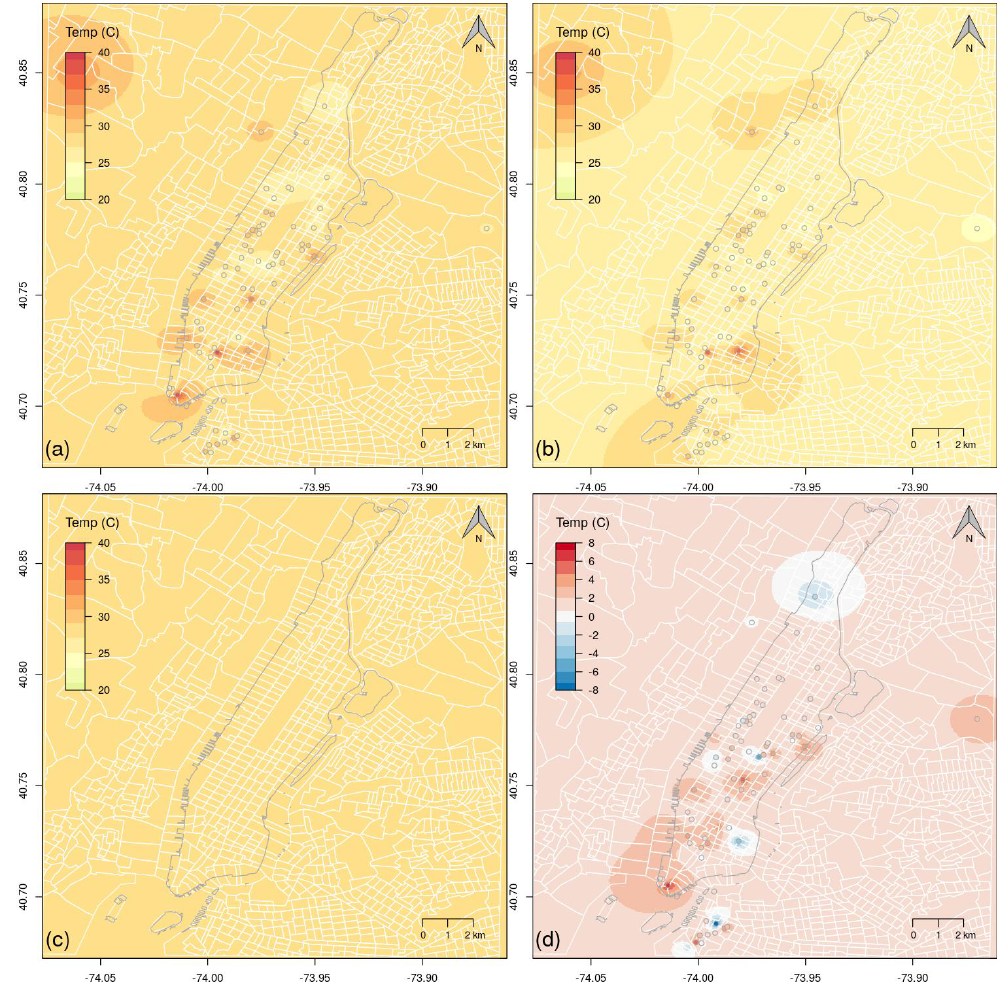
Figure 7. AnEn spatial downscaling for 8 August 2016 and forecast lead time 16 (12 p.m. local time)—The figure shows the observed values from the WU stations ( a ), the AnEn ensemble mean ( b ), the NAM-NMM prediction ( c ) and the difference between the PWSs and the AnEn ensemble mean ( d